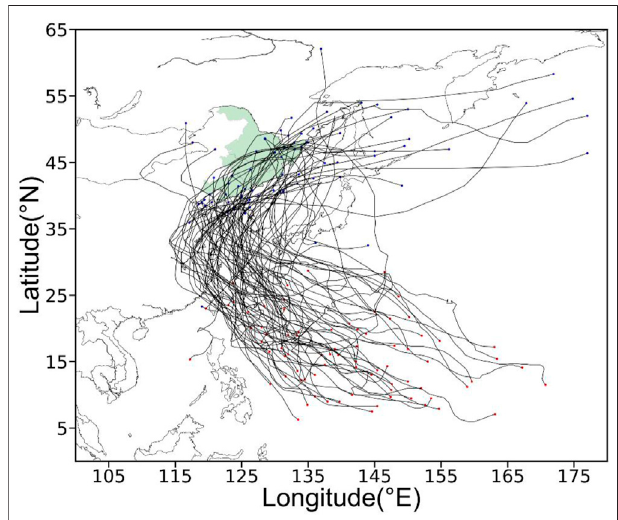
FIGURE 1 | The tracks of TCs that can in fl uence Northeast China (NEC) during 1949 and 2019. The red (blue) dots represent the genesis (dissipation) locations of